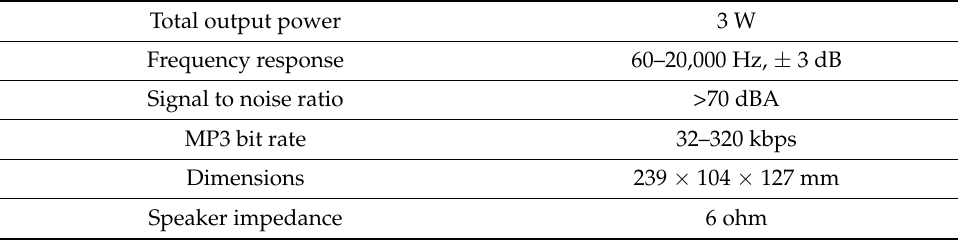
Table 2. Specifications of iPhone 6.